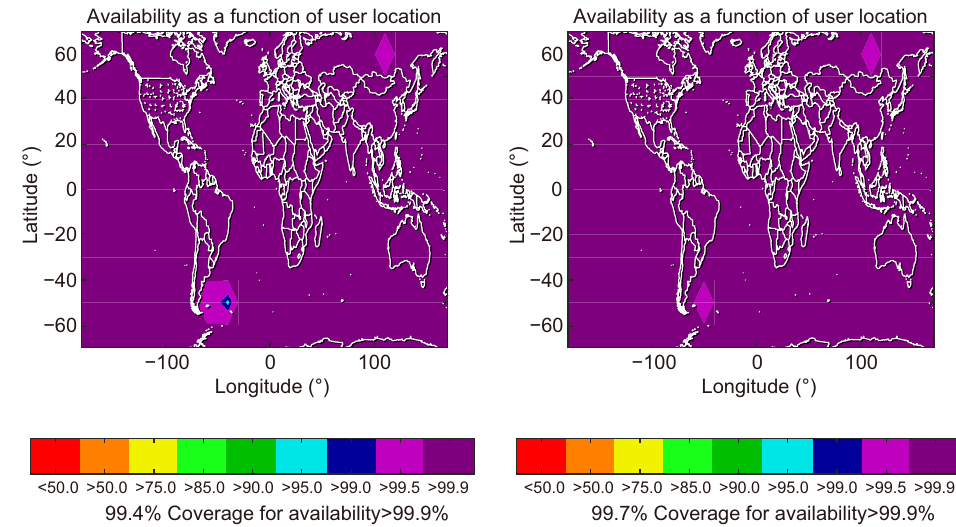
Fig. 6 Availability for PPP-AR (left) and PPP-RTK (right) models as a function of user location based on HAL